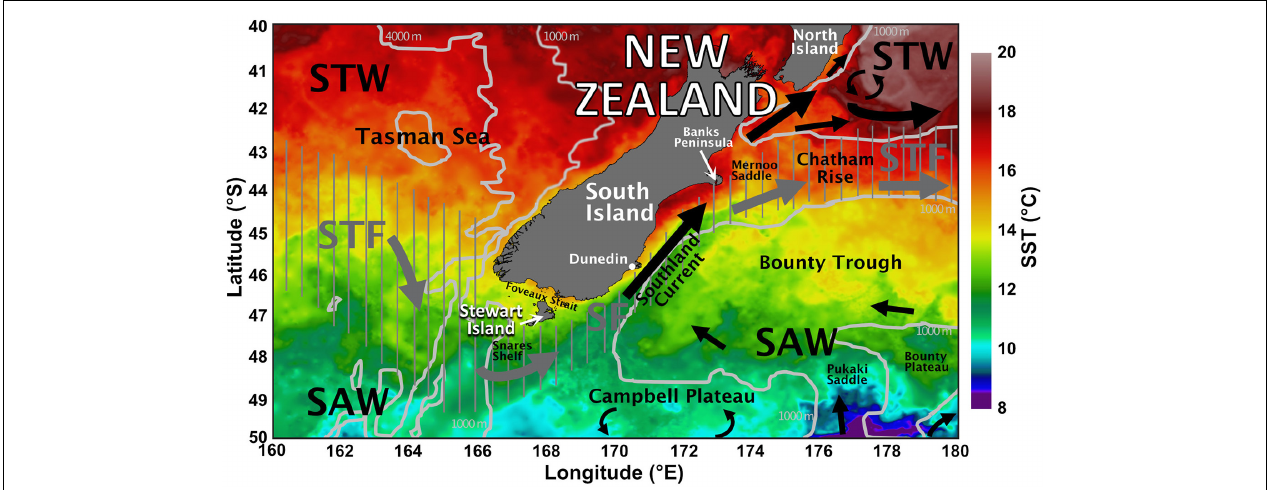
FIGURE 1 | Regional oceanographic setting of the South Island of New Zealand. 1,000 and 4,000 m bathymetric contours are shown and major bathymetric features are labeled. Sea surface temperature (SST) dataset is a composite reanalysis of a number of SST products for 2012/01/21 NASA’s JPL’s GHRSST MUR Level 4 SST Analysis (JPL MUR Measures Project, 2015) accessed in July 2021. Major water masses and oceanic fronts after Neil et al. (2004). STW, Subtropical Water, SAW, Subantarctic Water, STF, Subtropical Front, SF, Southland